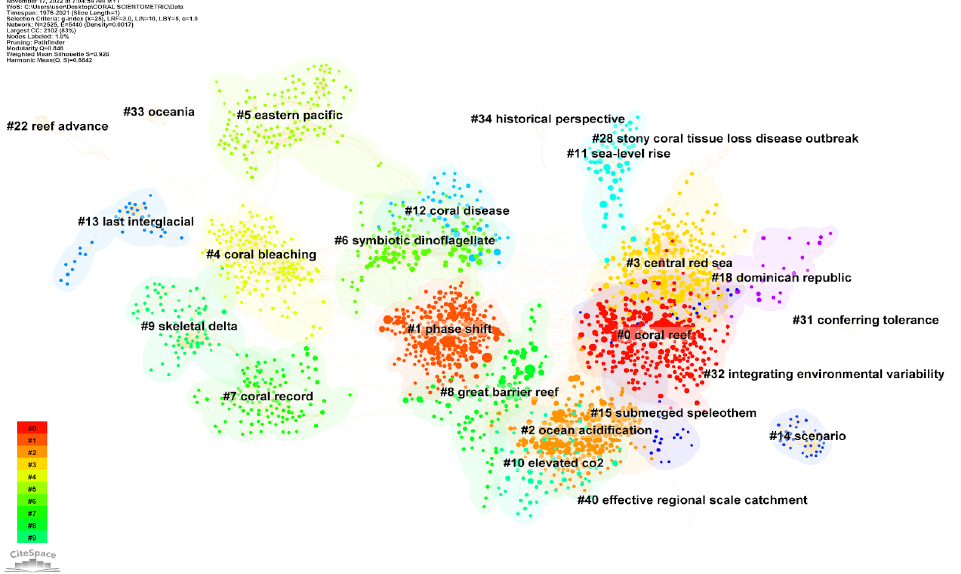
Figure 7. The reference co-citation research cluster network. Based on a one-year interval, a 24-cluster network of document co-citation with burst detection from 1976 to 2021. Node sizes are proportional to the frequency of the publications’ co ‐ citations.